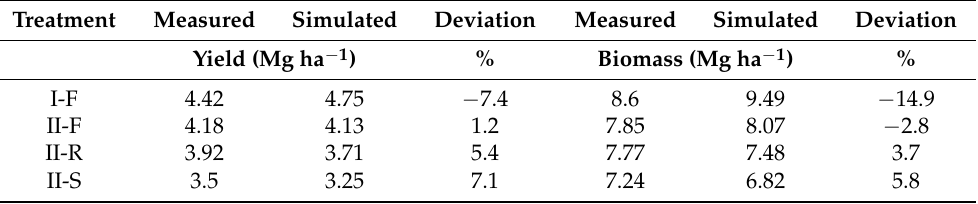
Table 4. Simulation results of yield and biomass for calibration datasets of common bean (full (F) and deficit (R and S) irrigation treatments), obtained from two sowing periods, I (spring) and II (late spring) in 2020, and deviation from measured values.